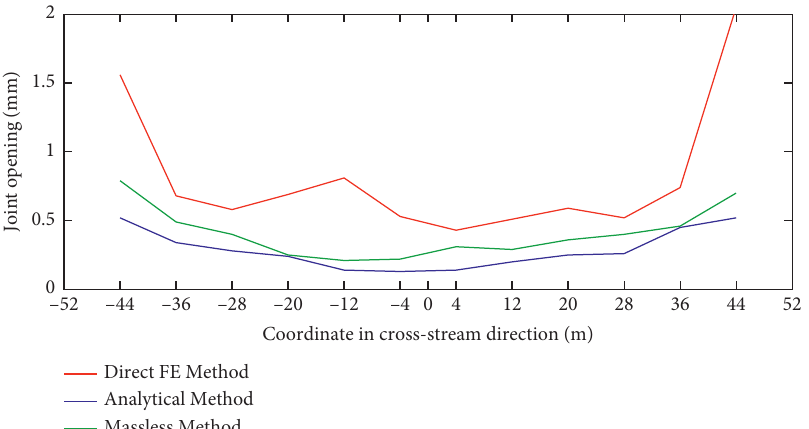
Figure 15: Maximum envelope of joint opening at crest due to the Taft earthquake for foundation modelling using the direct FE method, the analytical method, and the massless method.